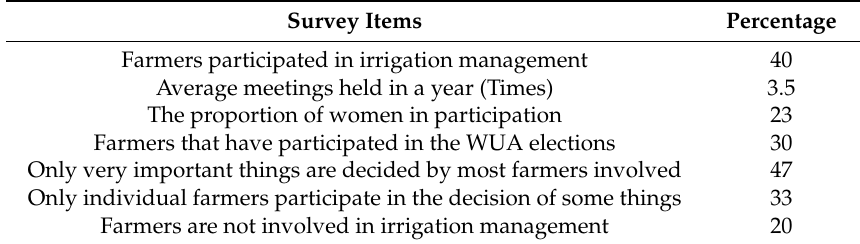
Table 4. Farmers’ participation level in WUAs and decision-making process of